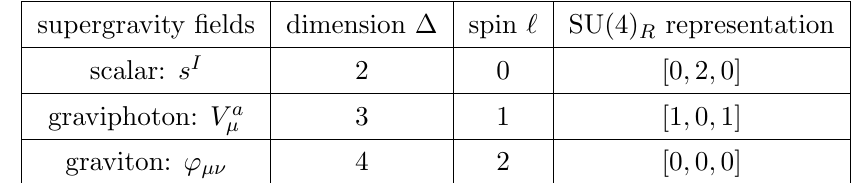
Table 1. The relevant supergravity (cid:12)elds and their quantum numbers.